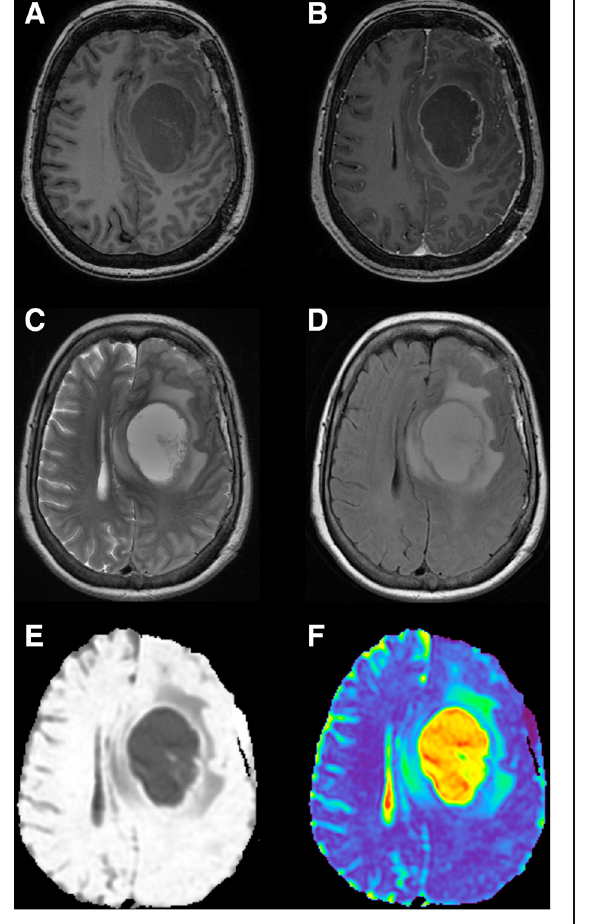
Fig. 1 Conventional MR sequences in the axial plane for the assessment of GB. a T 1 -weighted imaging. b Post-gadolinium T 1 -weighted imaging. c T 2 - weighted imaging. d Fluid-attenuated inversion recovery (FLAIR). e Diffusion-weighted imaging (DWI). f DWI-derived mapping with the calculation of apparent diffusion coefficient